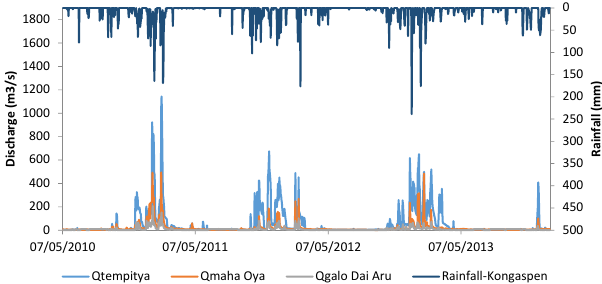
Figure 2. Historical discharge data used for flood modelling against rainfall data in the Mundeni Aru River